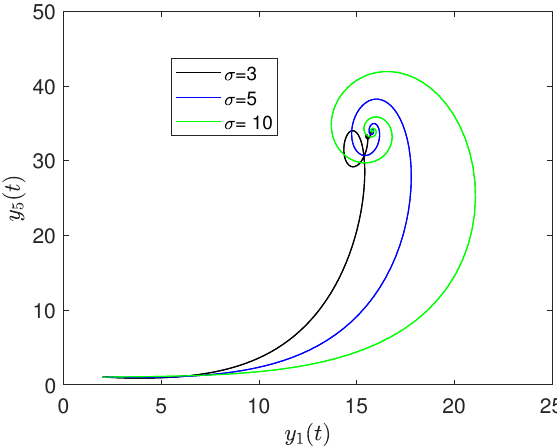
Figure 51. Phase portraits of y 1 and y 5 when varying σ